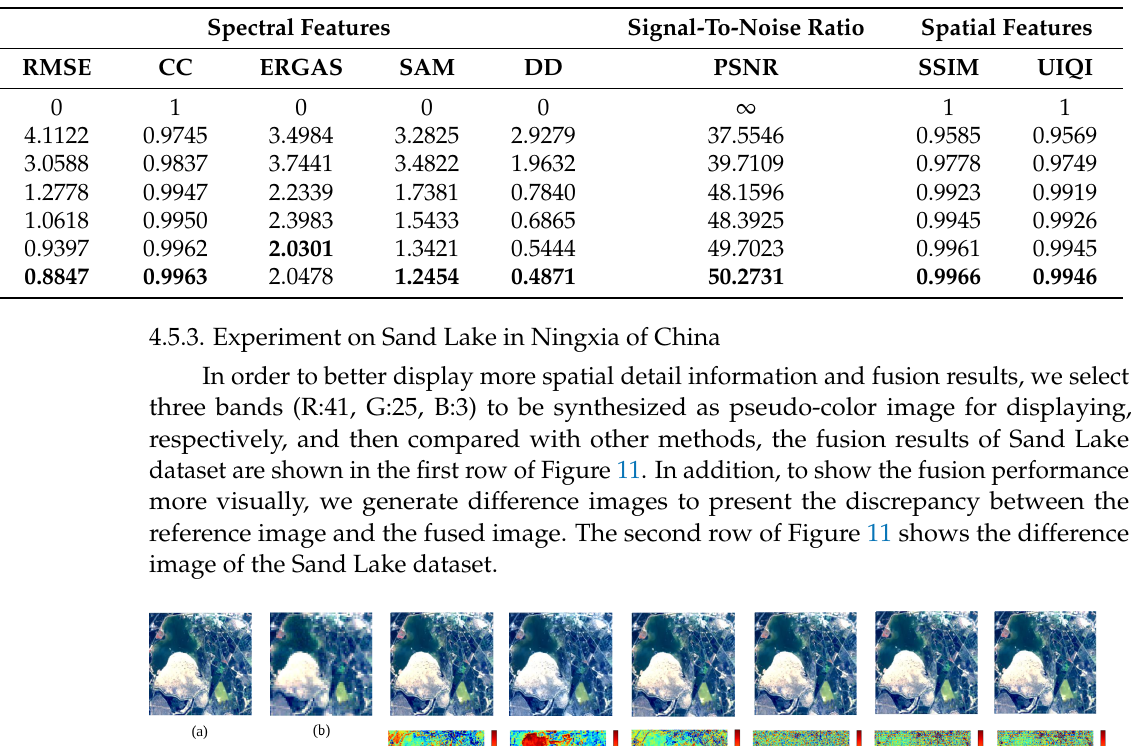
Table 3. Quality evaluation for Washington DC dataset.